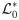
An alternating link L0* with negative writhe that is the realization of a 4.5 turn double crossover cube link.